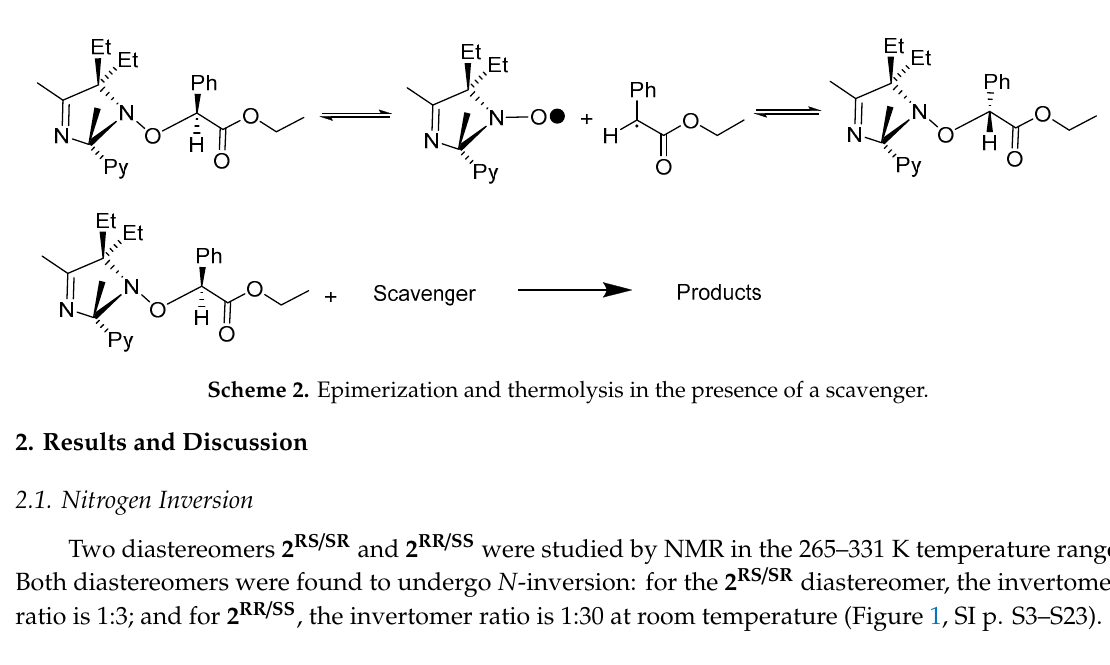
Figure 1. 1 H-NMR spectra in the region of the proton at the tertiary chiral carbon center for the two diastereomers 2 RS/SR and 2 RR/SS . For each diastereomer, the highlighted regions correspond to the respective invertomers.